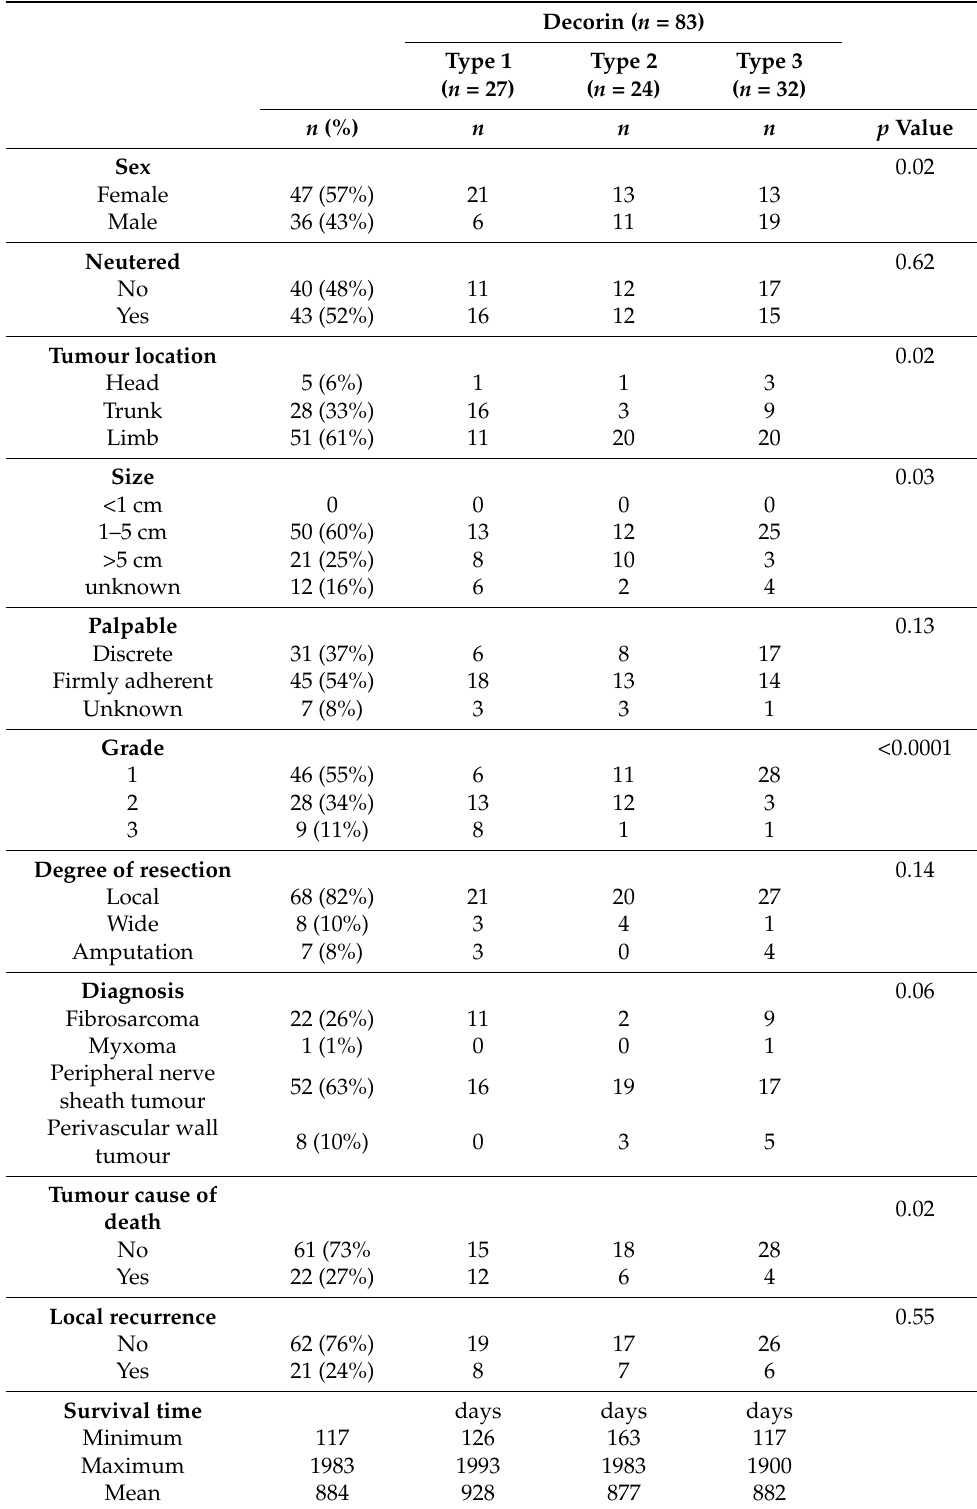
Table 3. Results from chi-square analysis for different tumour characteristics and decorin